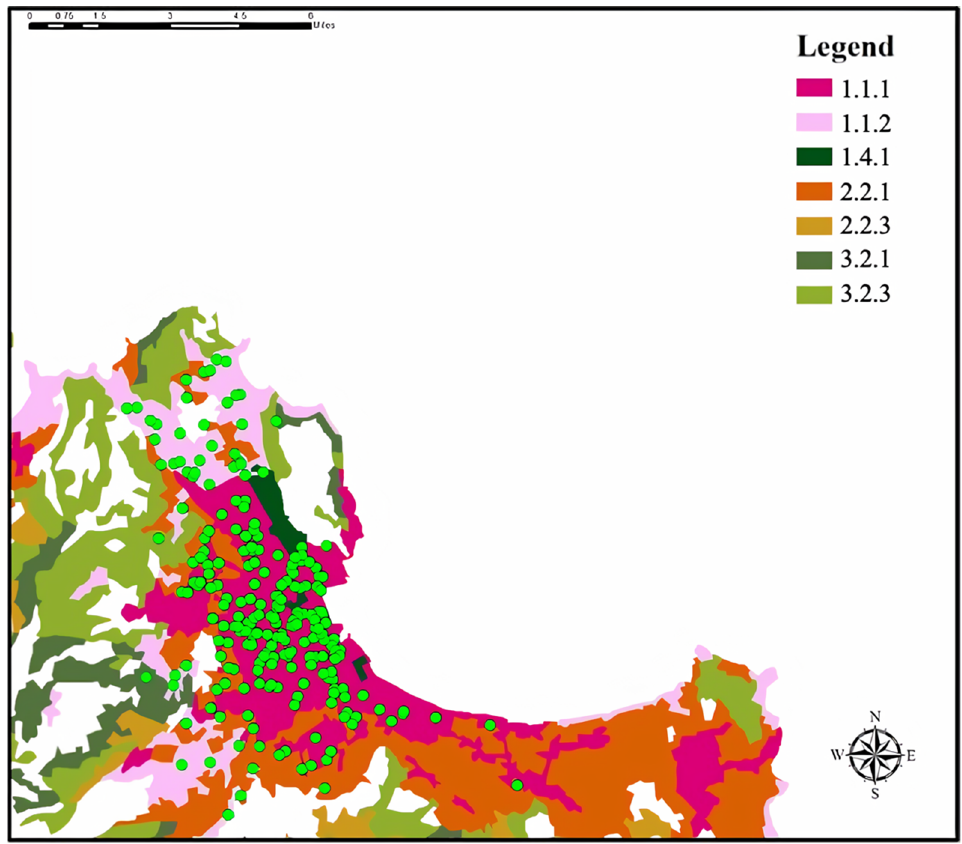
Figure 2. CLC category map of geo-coded children. Green points indicate the residence of each child and colored polygons identify the CORINE Land Cover categories.